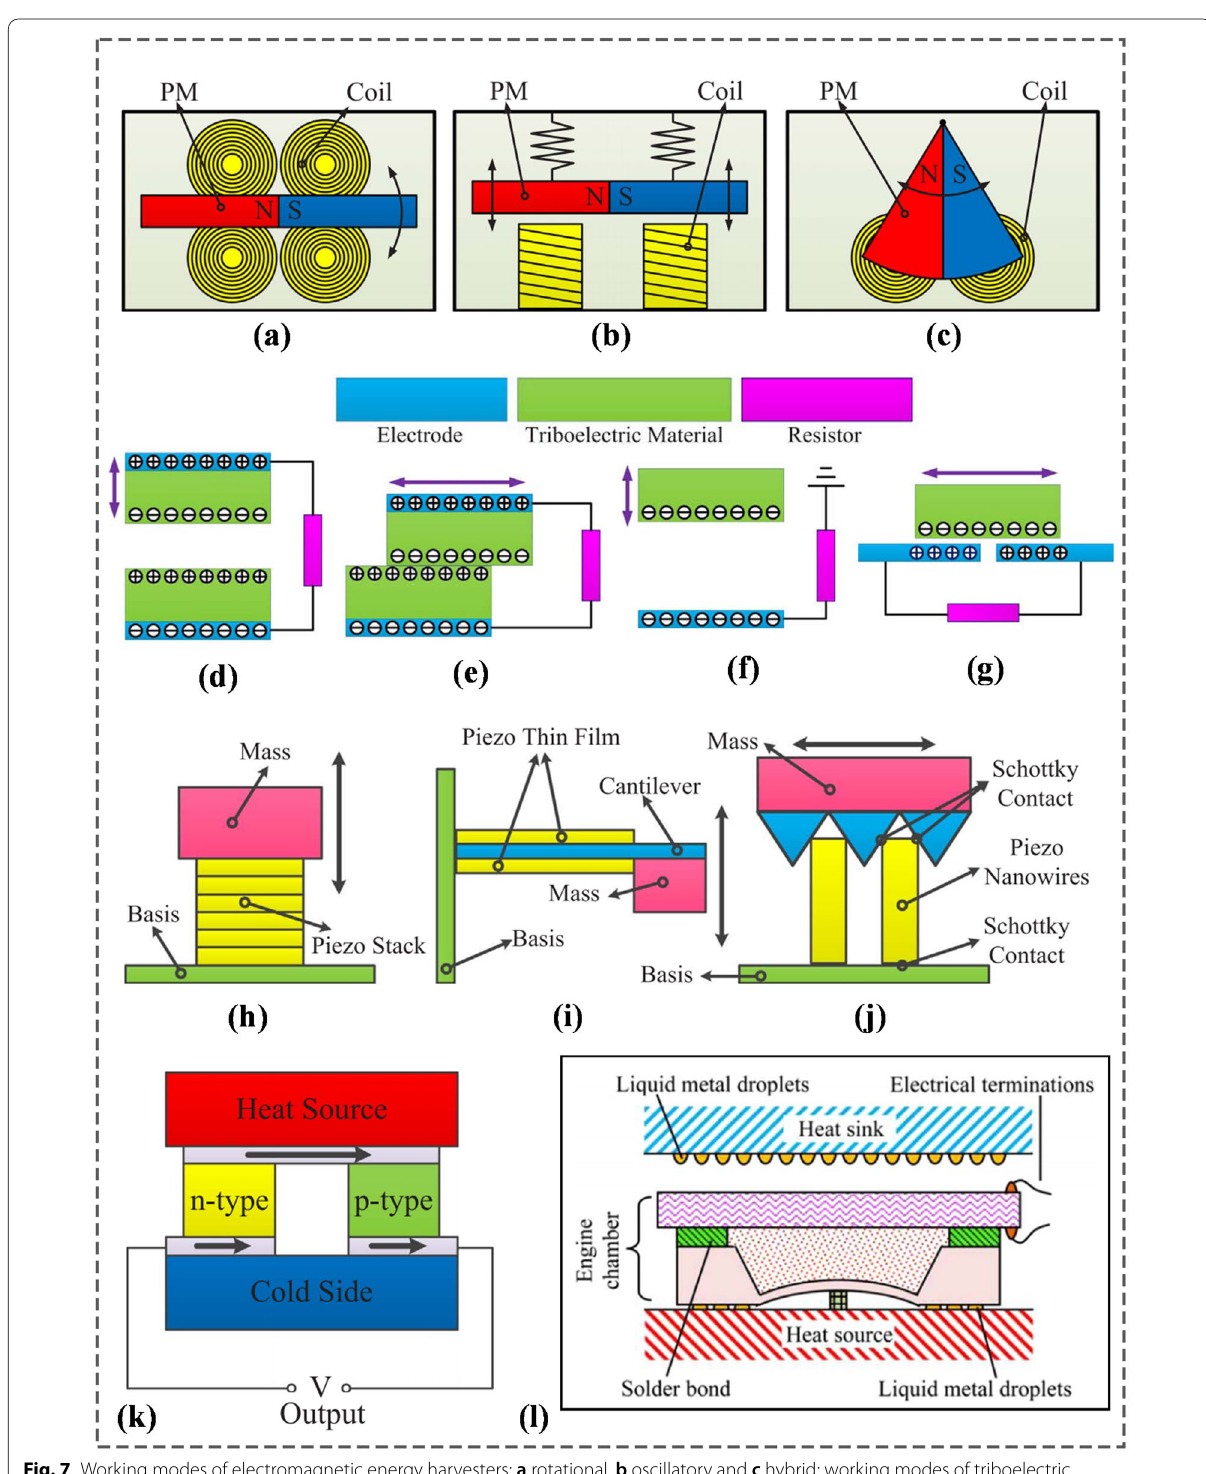
Fig. 7 Working modes of electromagnetic energy harvesters: a rotational, b oscillatory and c hybrid; working modes of triboelectric nanogenerators d vertical contact-separation mode, e in-plane contact-sliding mode, f single-electrode mode and g freestanding mode working modes of piezoelectric energy harvesters: h d 33 working mode, i d 31 working mode and j piezotronic working mode; k schematic diagram of a thermoelectric nanogenerator l schematic of the micro pyroelectric energy harvester [39] (Images are re-used with the permission of the